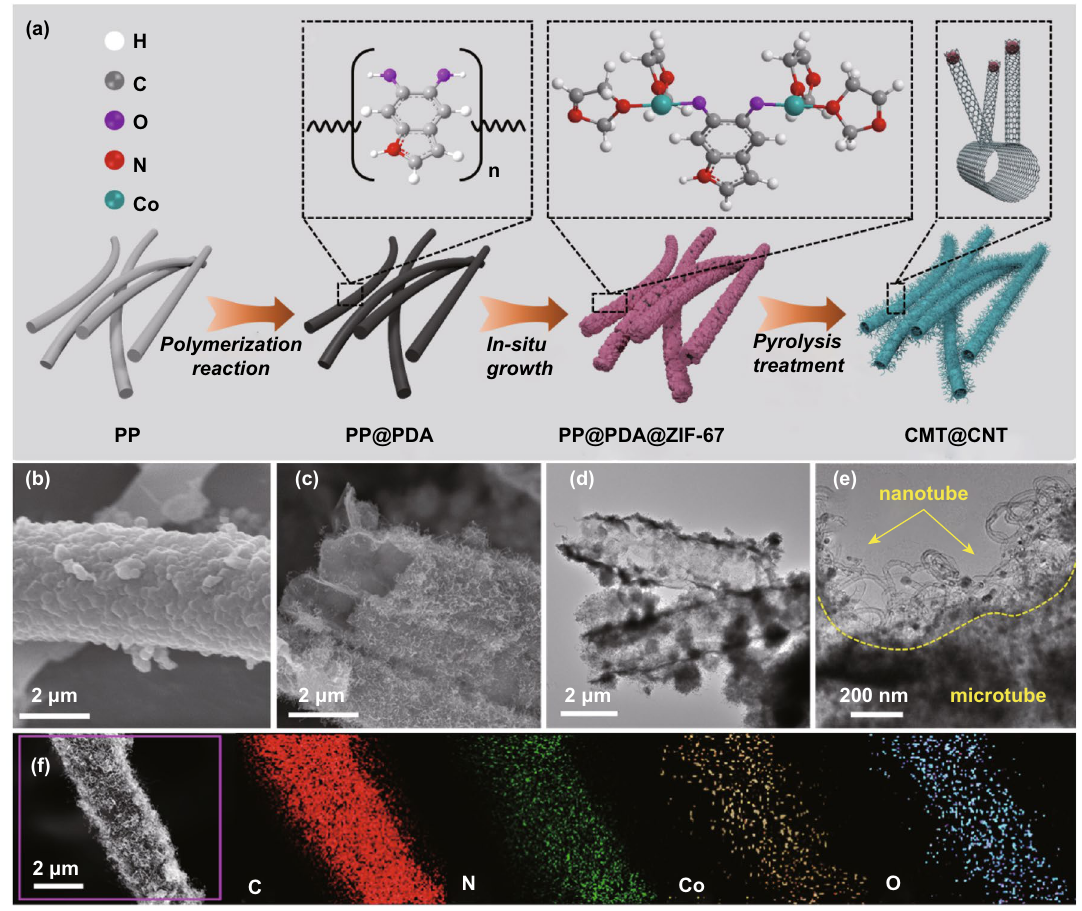
Fig. 1 a Schematic illustration for the synthesis of CMT@CNT. SEM images of b PP@PDA@ZIF-67 and c CMT@CNT. d , e TEM and f SEM images and the corresponding elemental mapping of